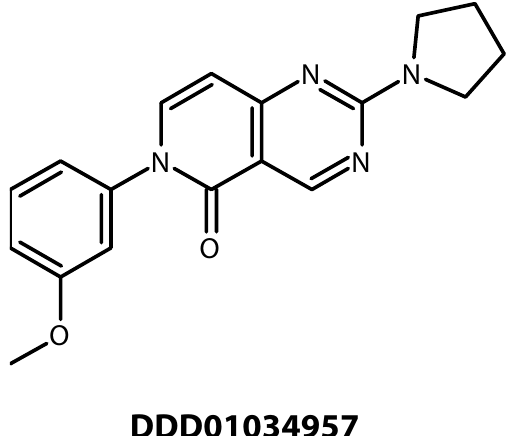
Figure 1. The chemical structure of DDD01034957 that was identified in a previous screen against P. falciparum asexual development and reportedly showed an IC 50 of 172nM 4 .